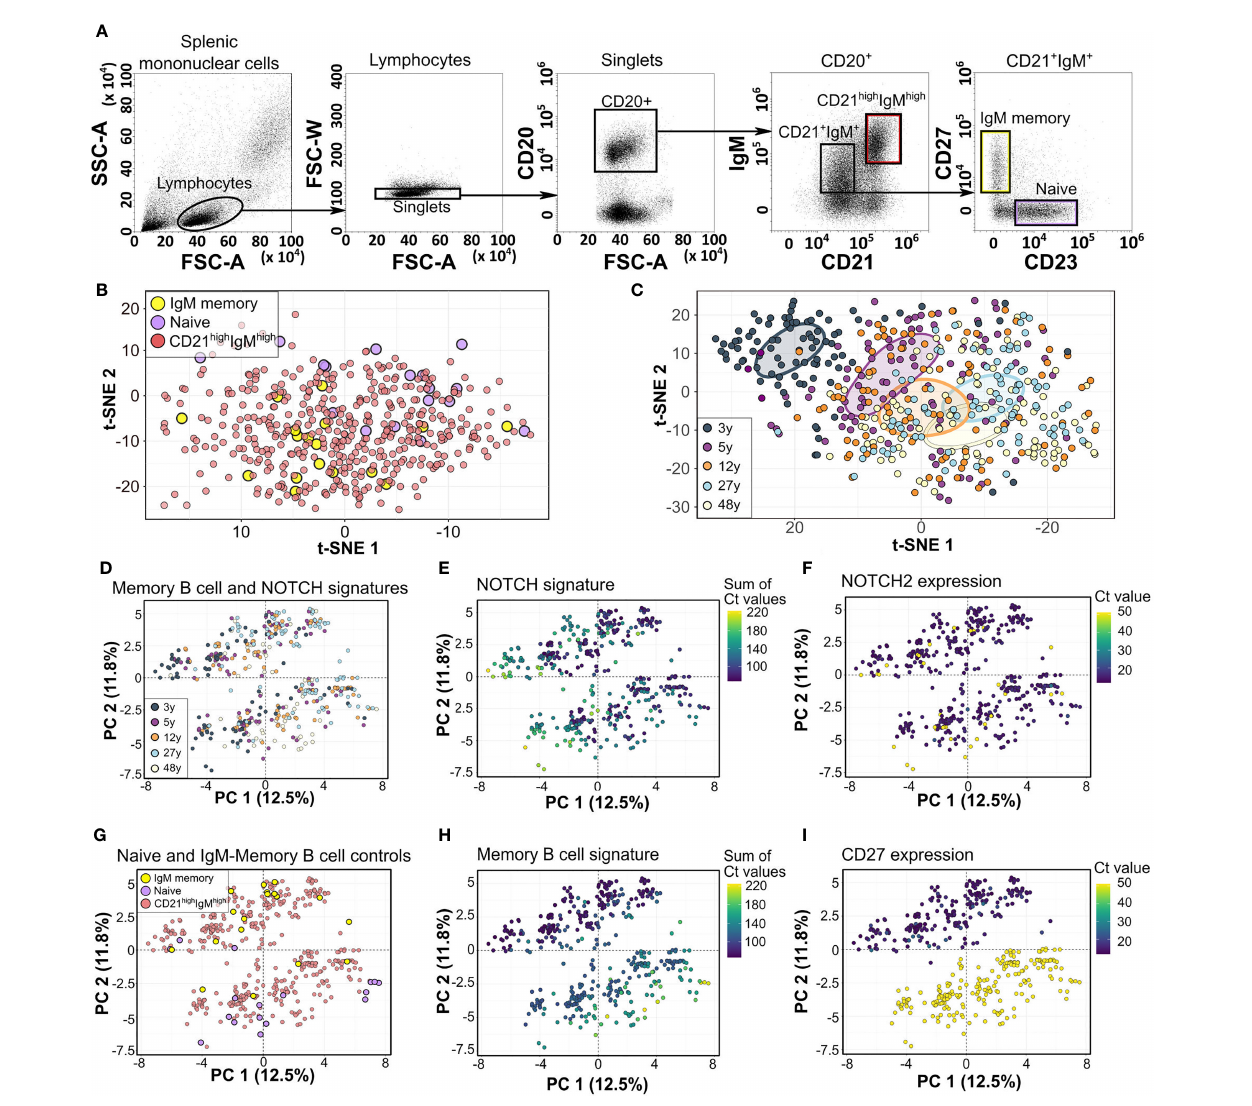
FIGURE 1 | Fluidigm 96.96 analysis of human splenic CD21 high IgM high zone B cells. (A) Gating strategy of human splenic NBCs, IgM MBCs, and CD21 high IgM high B cells. (B) Unsupervised t-SNE analysis of 95 genes and 460 cells from 5 donors. (C) Unsupervised t-SNE analysis of most differentially expressed genes (MANOVA q < 0.05, 31 genes, Table S2 ) among sMZ B cells from fi ve donors. Colored circles denote the centers of mass (top 10%) as determined by ggplot. Individual donors are shown in Figure S1A . (D) Supervised PCA of 23 genes associated with hallmark molecules distinguishing NBCs from MBCs, sMZ B cells, and